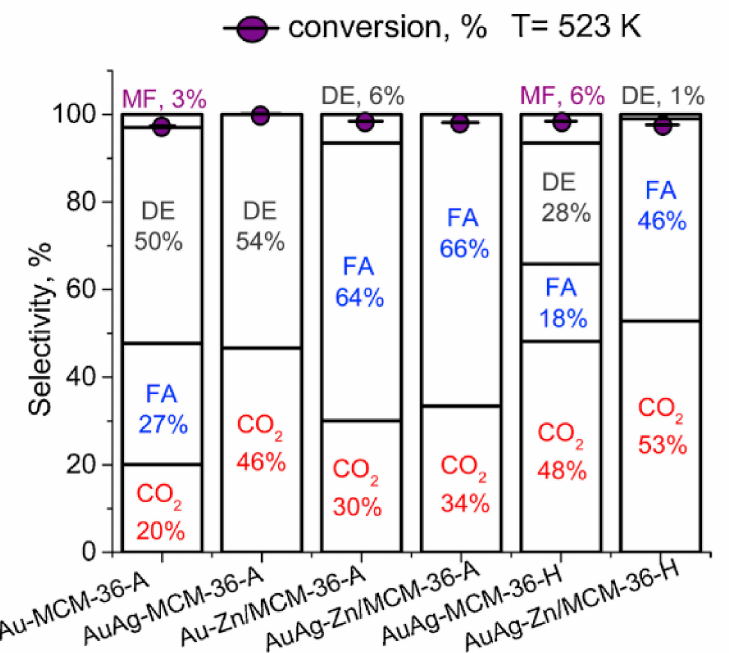
Figure 42. Selectivity of mono and bi-metallic catalysts investigated by Kaskow et al. [224] for the MeOH oxidation at close to 100% conversion and 250 ◦ C. FA = Formaldehyde; DE = dimethyl ether; MF = methyl formate. Feed: 23.4/3.2/2.5 mL/min of Ar/O 2 /MeOH. Reprinted from [224] Copyright © (2020), with permision from